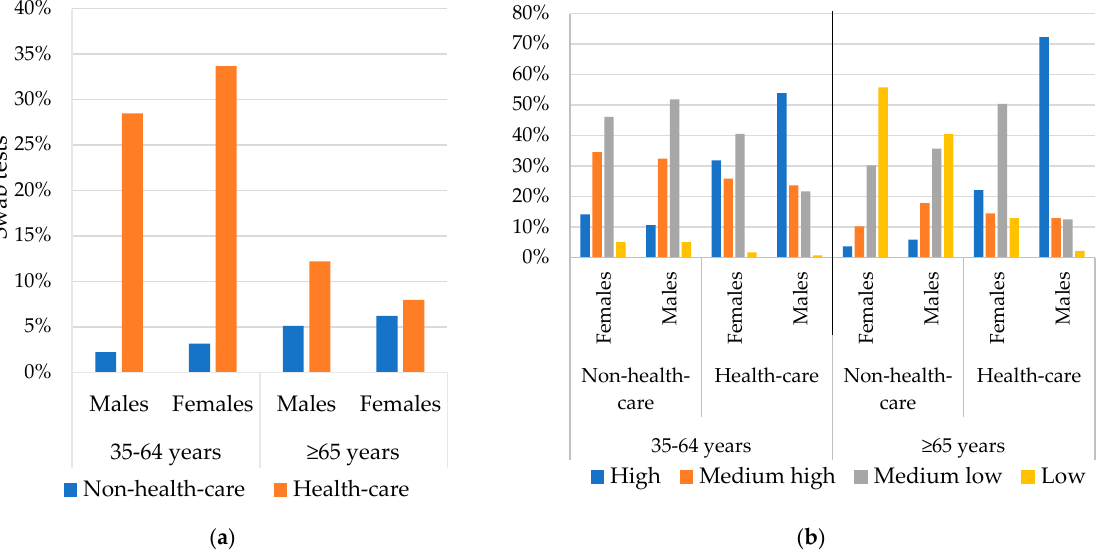
Figure 1. Comparison between healthcare workers and non-healthcare workers regarding ( a ) access to swabs by age and gender; ( b ) distribution of population according to educational level, by age and gender individual Index of Socioeconomic Disadvantage (ISD).